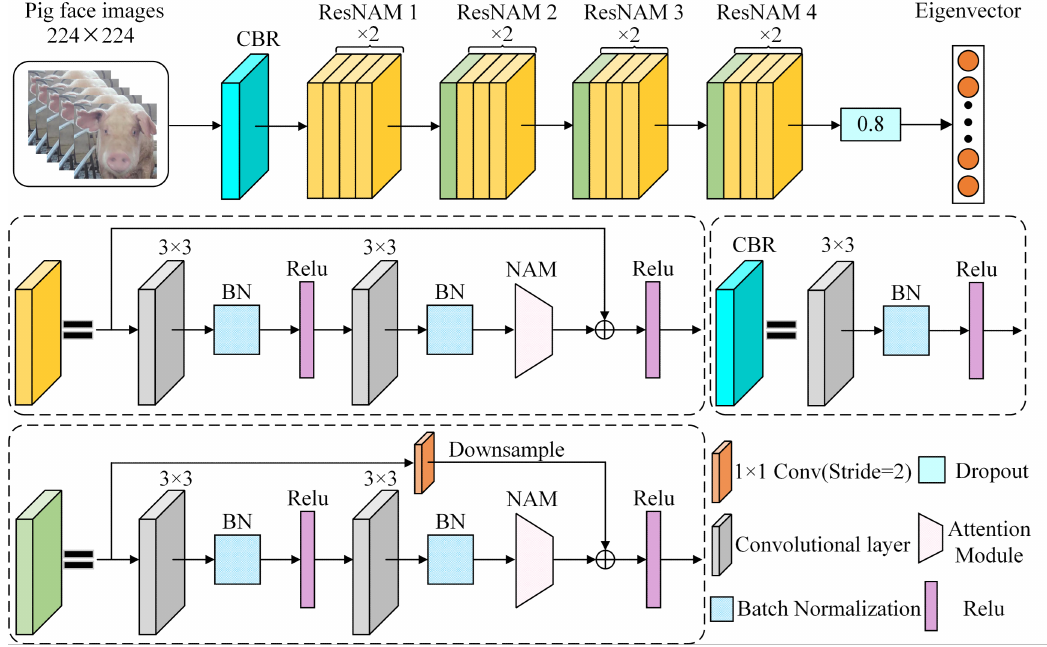
Figure 3. Structure of the backbone for feature extraction from pig face